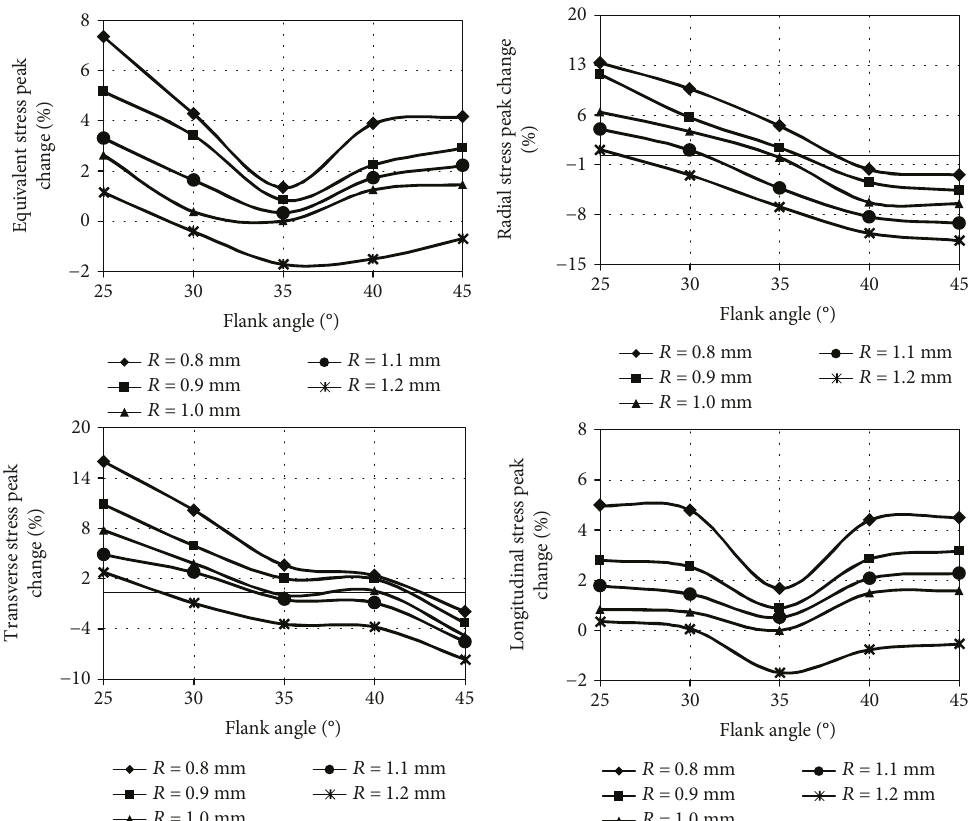
Figure 10: The in fl uence of fl ank angle and rounding arc on stress peaks during implant axial loading with a force of 1000N.